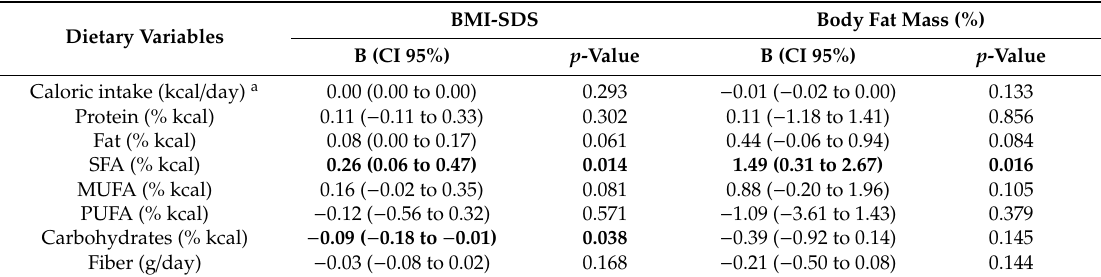
Table 4. Associations between dietary variables and adiposity or BMI-SDS.